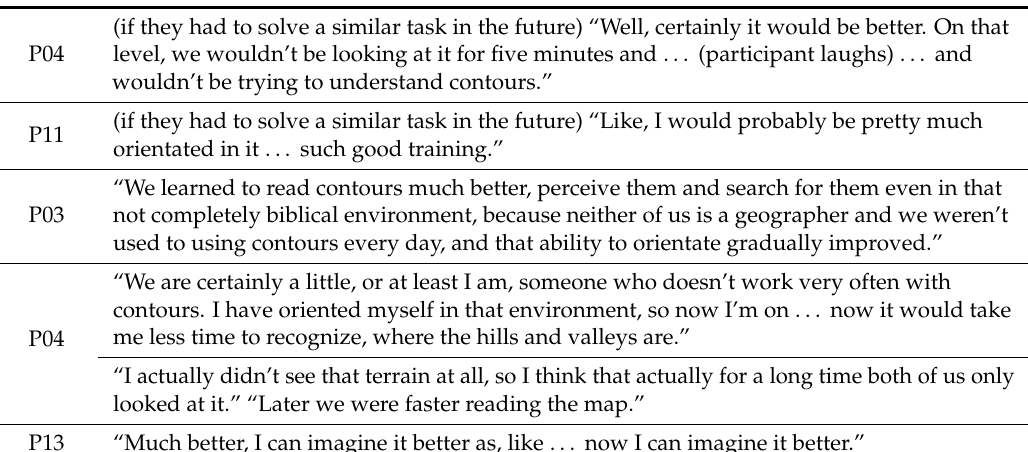
Table 4. Verbatim excerpts of statements by participants: Learning a skill to work with maps.